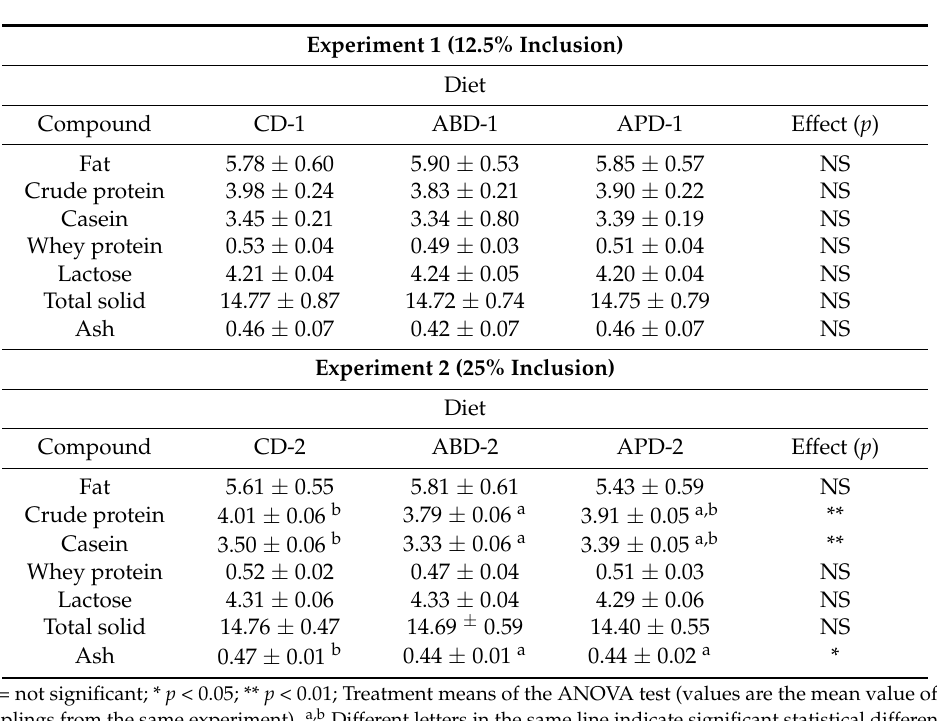
Table 3. Milk composition (g/100 mL) of Murciano-Granadina goats fed on diets containing or not containing artichoke by-products (plant and outer bracts) in Experiment 1 (12.5% include) and Experiment 2 (25%